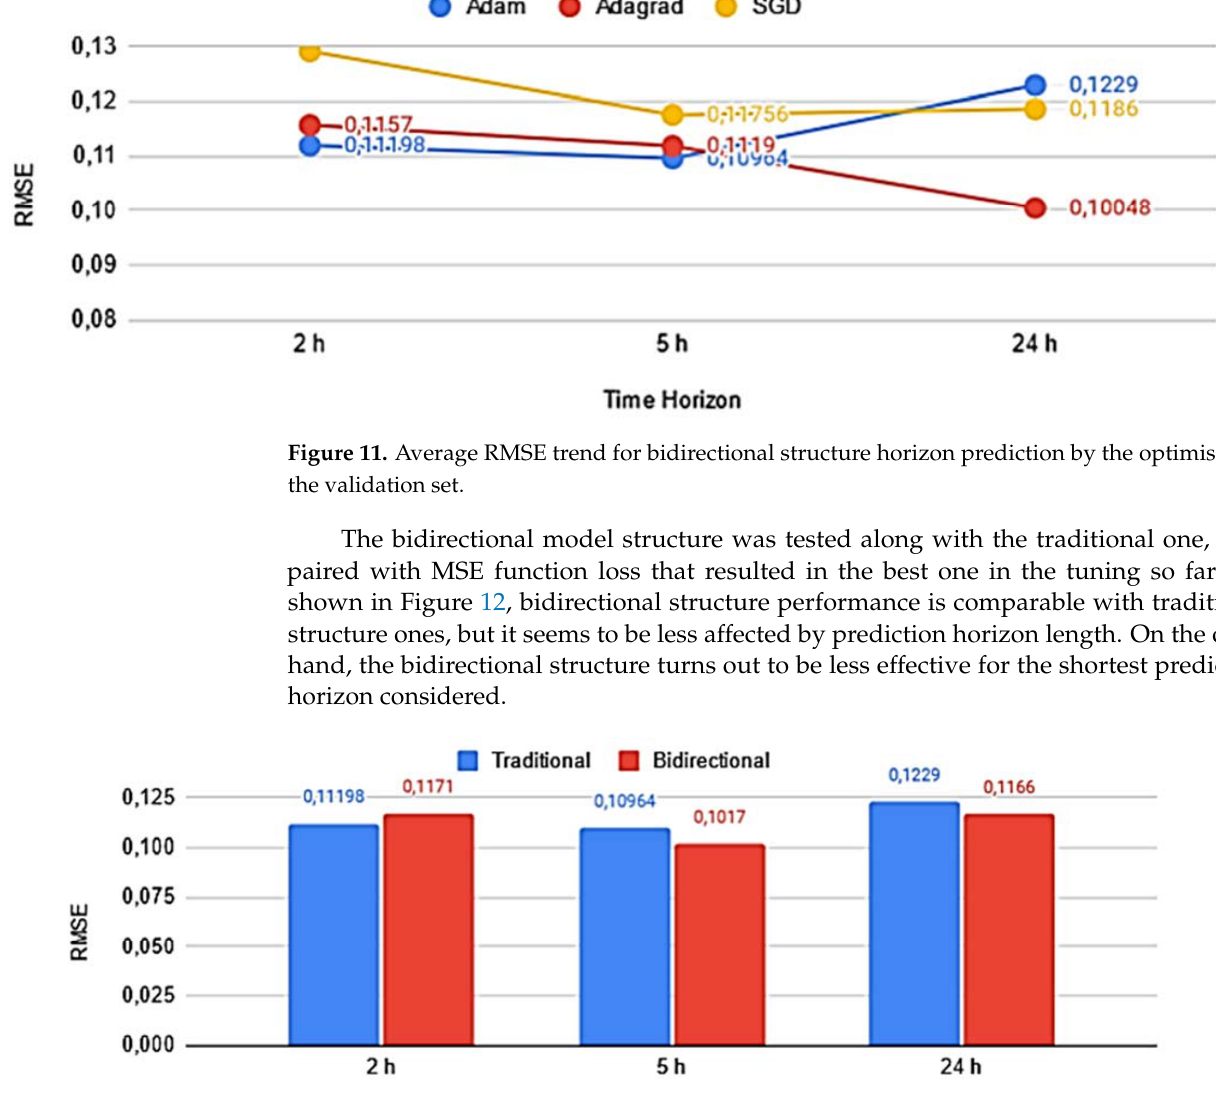
Figure 11. Average RMSE trend for bidirectional structure horizon prediction by the optimiser for the validation set.